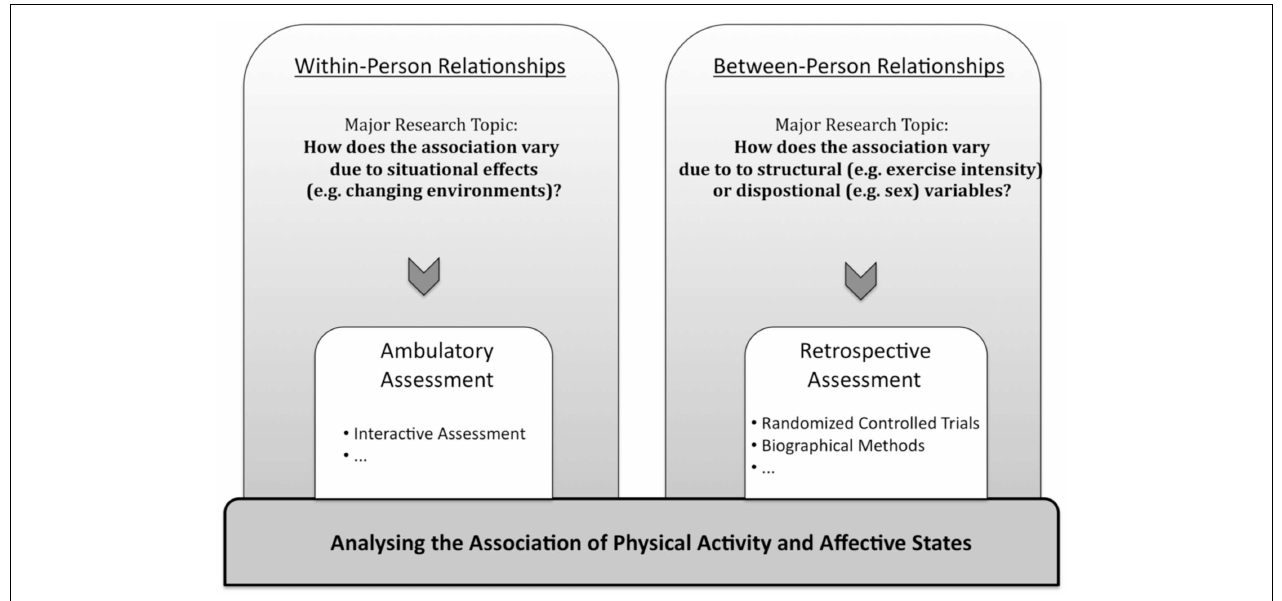
FIGURE 1 | Distinction between within-subject and between-subjects relationships in major research topics and assessment approaches